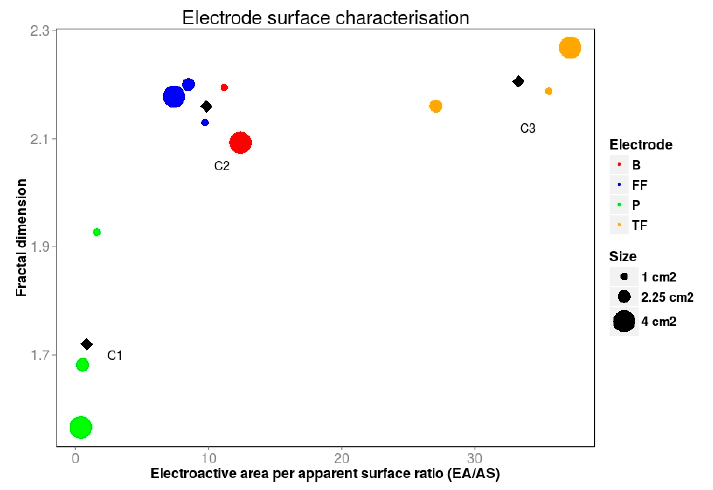
Figure 7. Relationship between fractal dimension and EA/AS for each material tested. Black diamond points show the centroids of electrode clusters.